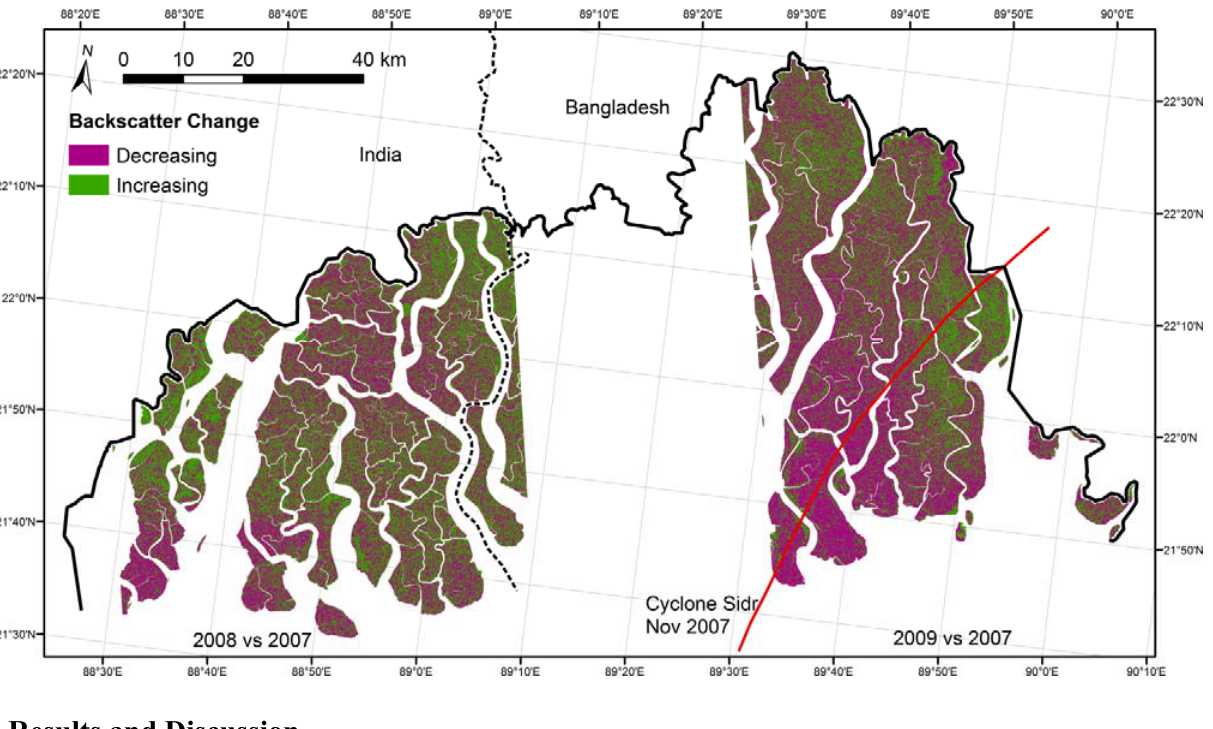
Figure 3. Recent habitat degradation in the Sundarbans. Purple areas correspond to areas of or closest to decreased backscatter (of at least 10%) for the periods 2007–2008 (for the west side of the Sundarbans) and 2007–2009 (for the east side of the Sundarbans). Green areas correspond to areas of or closest to increased backscatter over the same